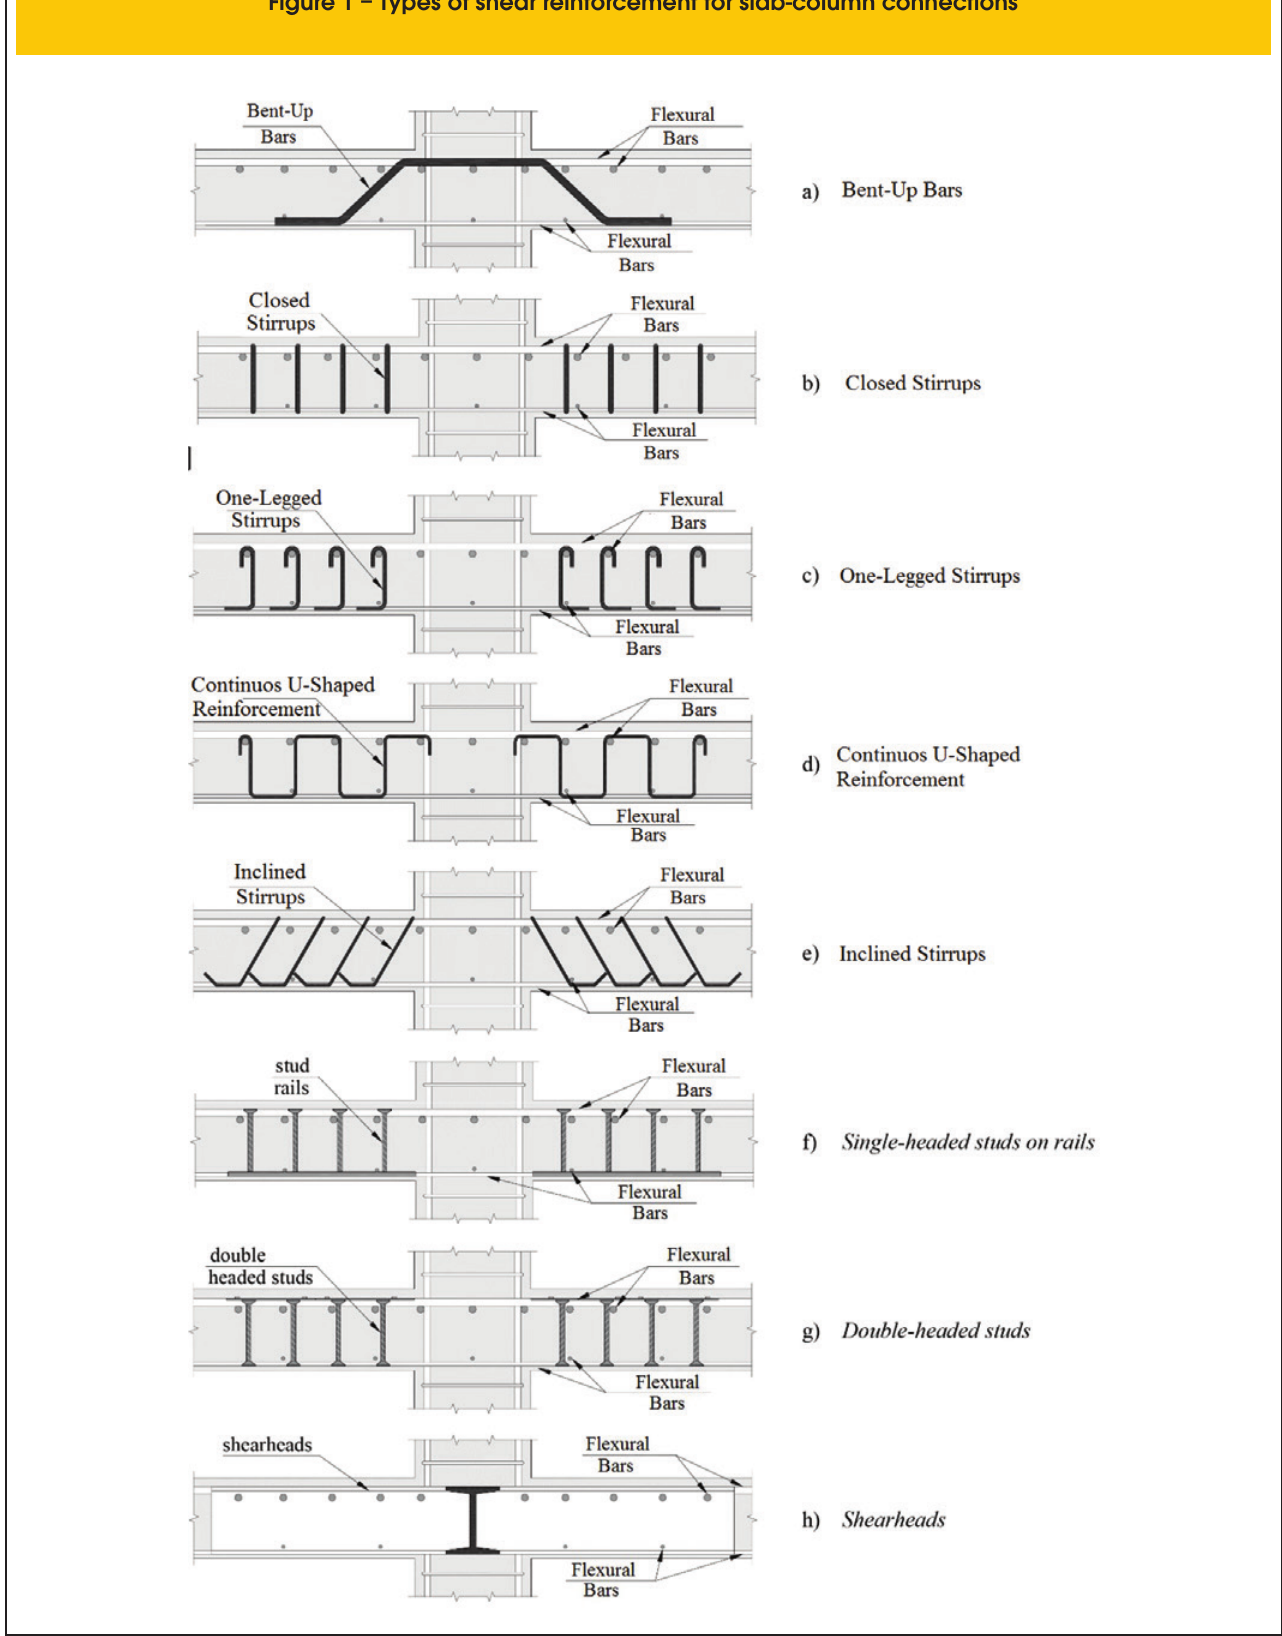
Figure 1 – Types of shear reinforcement for slab-column